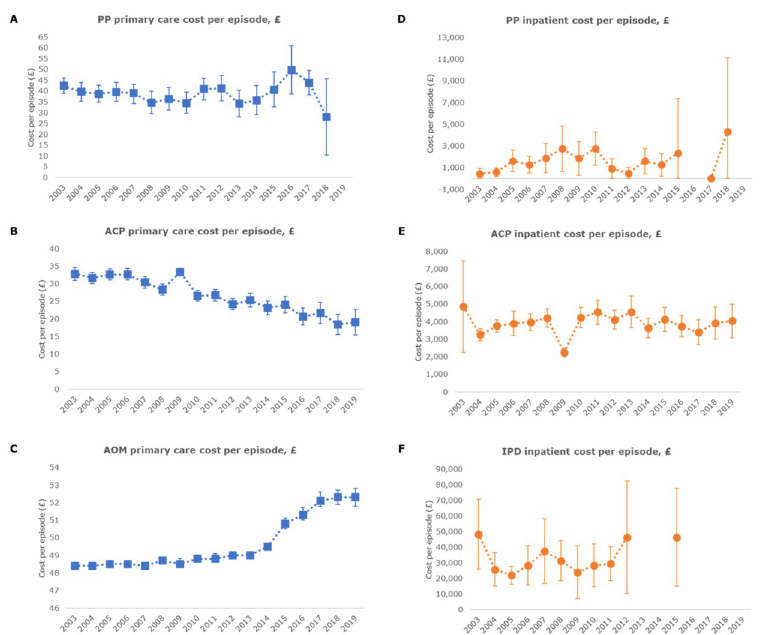
Fig 1. PP, ACP, AOM and IPD costs per episode by study year. PP primary care cost per episode (A), ACP primary care cost per episode (B), AOM primary care cost per episode (C), PP Inpatient cost per episode (D), ACP Inpatient cost per episode (E) and IPD Inpatient cost per episode (F). For figures D and F, where the number of episodes were less than 5, the data are not shown, in accordance with CPRD and HES-APC data protection policies. ACP: all-cause pneumonia; AOM: acute otitis media; IPD: invasive pneumococcal disease; PP: pneumococcal pneumonia.